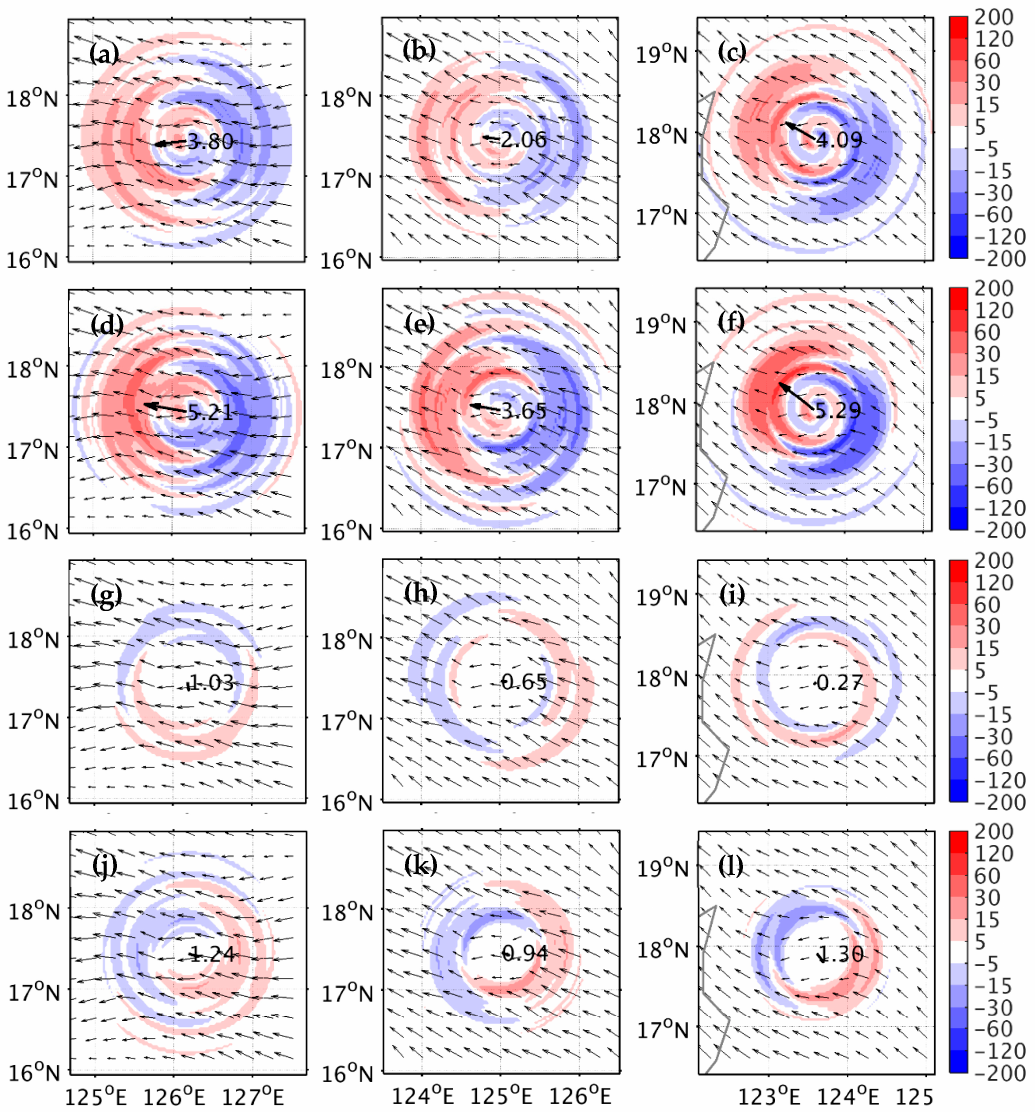
Figure 14. The WN-1 horizontal flow and PV tendency budget (shaded colors, 10 − 5 PVU s − 1 ) averaged in 1–8 km height for YT-CTL at 72 h for ( a ) net PV budget, ( d ) horizontal PV advection, ( g ) vertical PV advection, and ( j ) differential diabatic heating. ( b ), ( e ), ( h ), and ( k ) are the same as in ( a ), ( d ), ( g ), and ( j ), respectively, but at 84 h. ( c ), ( f ), ( i ), and ( l ) are the same as in ( a ), ( d ), ( g ), and ( j ), respectively, but at 96 h. The bold reference wind vector (in m s − 1 ) indicates the induced vortex translation velocity. The budget results are averaged within 1 h ahead of the analysis time.